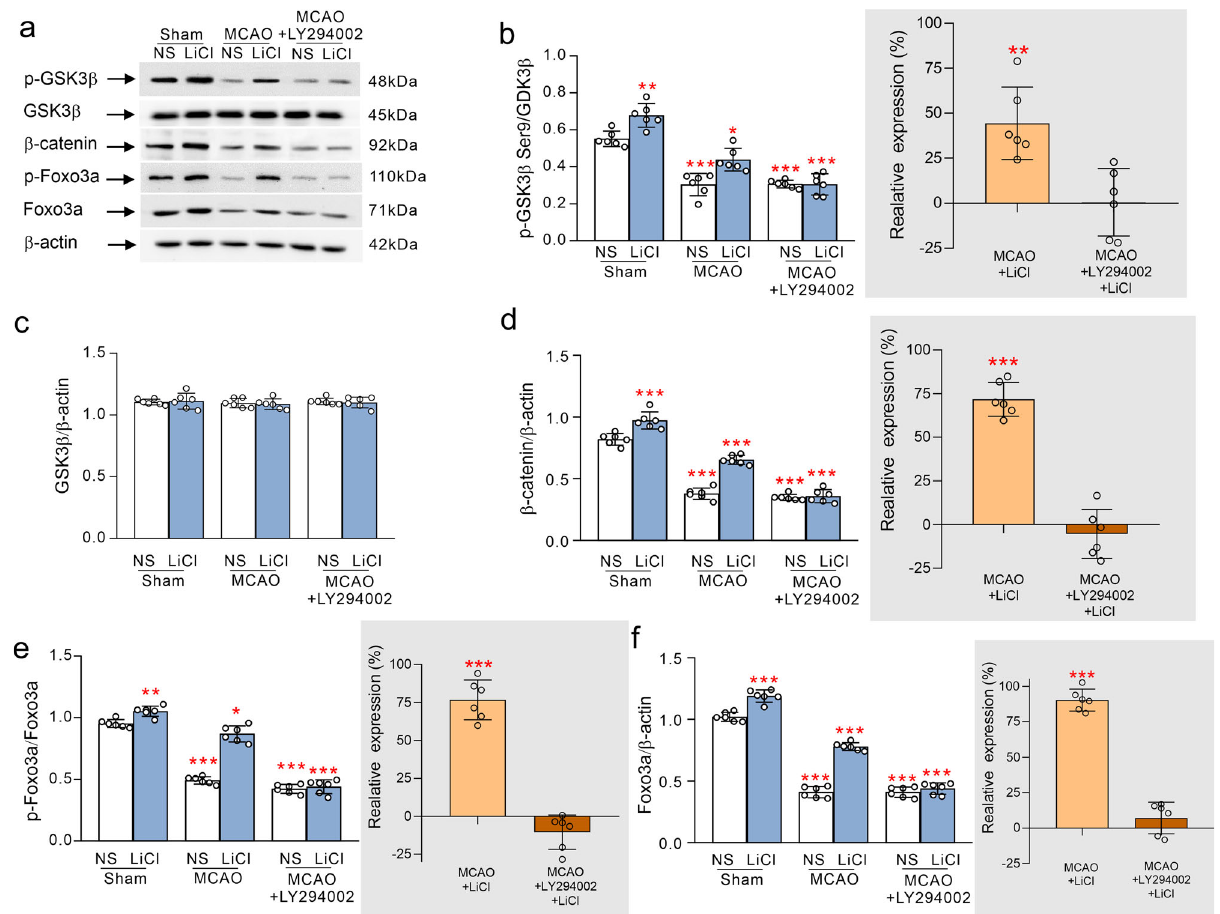
Fig. 3 The regulations of Li + in the cytoplasmic levels of GSK3 β , β -catenin and FoxO3a by stimulating AKT following ischaemia-reperfusion. a Representative protein bands for p-GSK3 β , GSK3 β , β -catenin, p-FoxO3a, FoxO3a and β -actin (the house-keeping protein) in cytoplasm. b – f Relative ratio of p-GSK3 β and GSK3 β is shown in b , the relative ratio of p-FoxO3a and FoxO3a is shown in e , and the normalised intensities of GSK3 β , β -catenin, FoxO3a by β -actin are shown in c , d and f , inserts on the right are the relative comparison with the respective MCAO groups. The protein levels were calculated and plotted as mean ± SD. N = 6 per group. Two-way ANOVA for comparisons including more than two groups; unpaired two-tailed t -test for two group comparisons. * p < 0.05, ** p < 0.01, *** p <